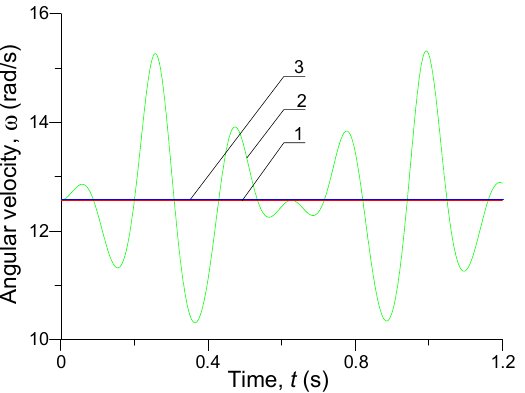
Figure 7. Rotational speed waveforms of three shafts: 1—first, 2—second, 3—third for the angles variable in time and equal to one another: α ( t ) 1,2 = α ( t ) 2,3 .